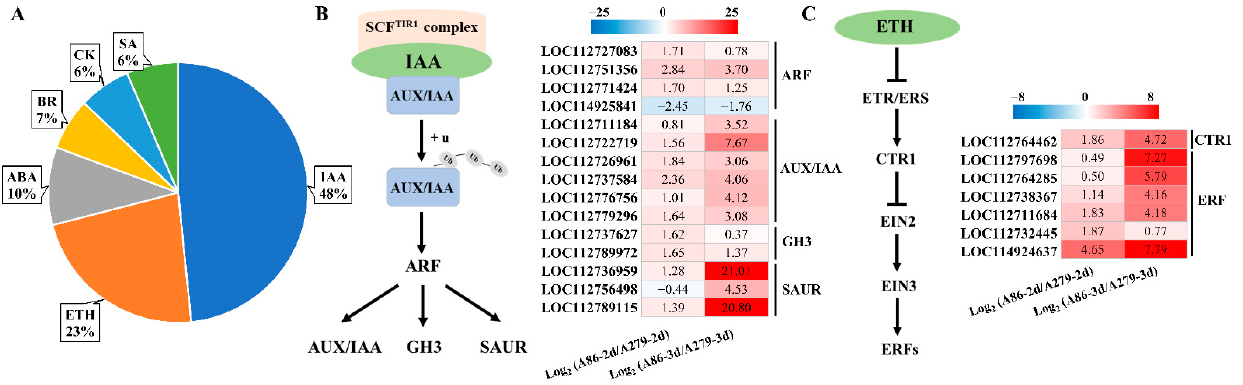
Figure 5. The expression of DEGs involved in hormone signal transduction. ( A ) Pie chart showing the frequency distribution of DEGs involved in hormone signal transduction. ( B , C ) Heat ‐ map showing the differences in the expression of representative genes related to the IAA and ETH signaling pathways.